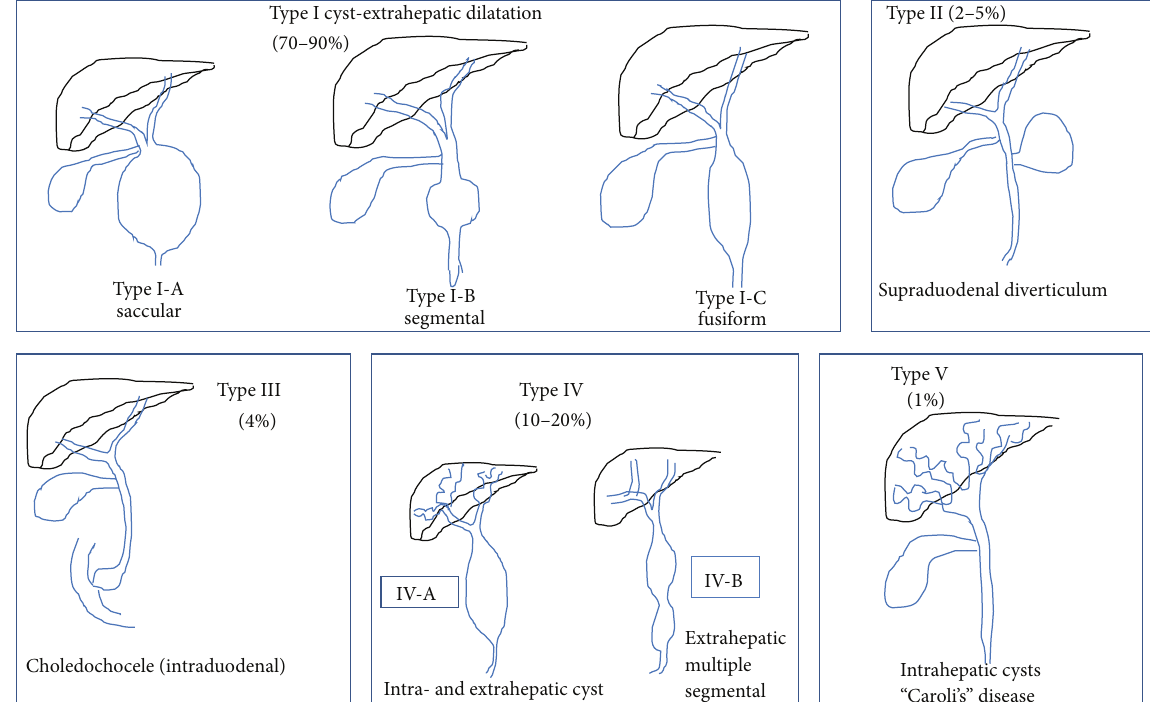
Figure 1: Todani’s classification of choledochal cyst.